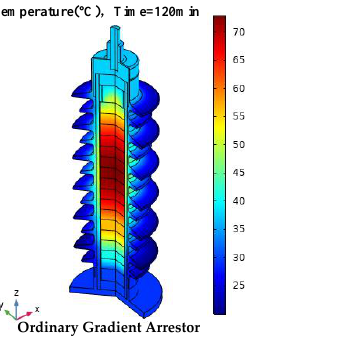
Figure 12. Temperature distribution of different valve arrestors at 1050 Hz for 120 min.